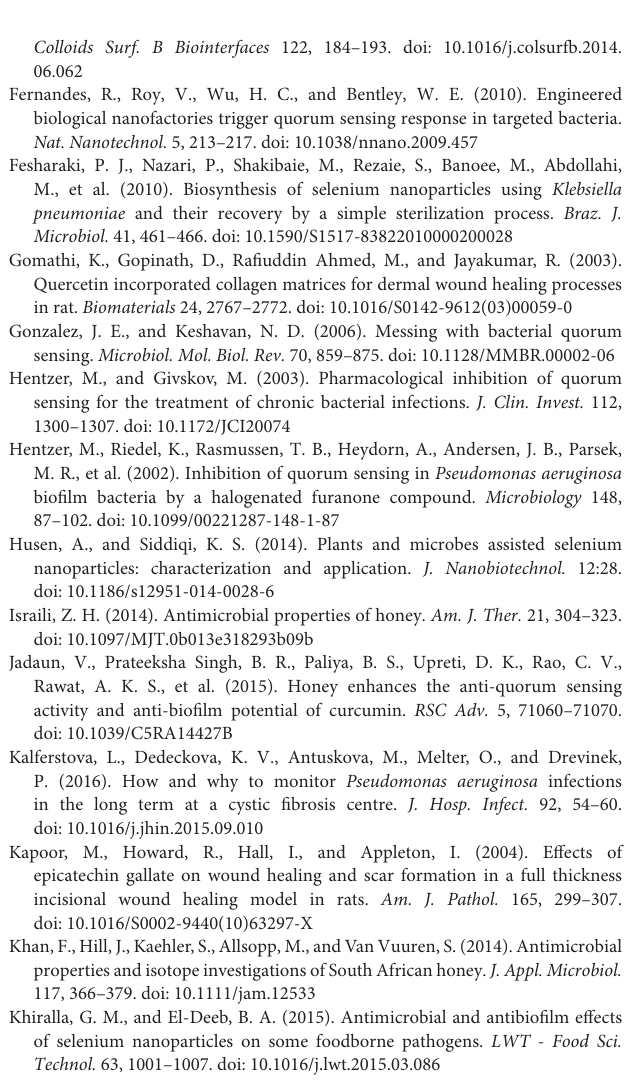
algorithm (LGA), considered one of the best docking methods docking studies. Both AutoGrid and AutoDock